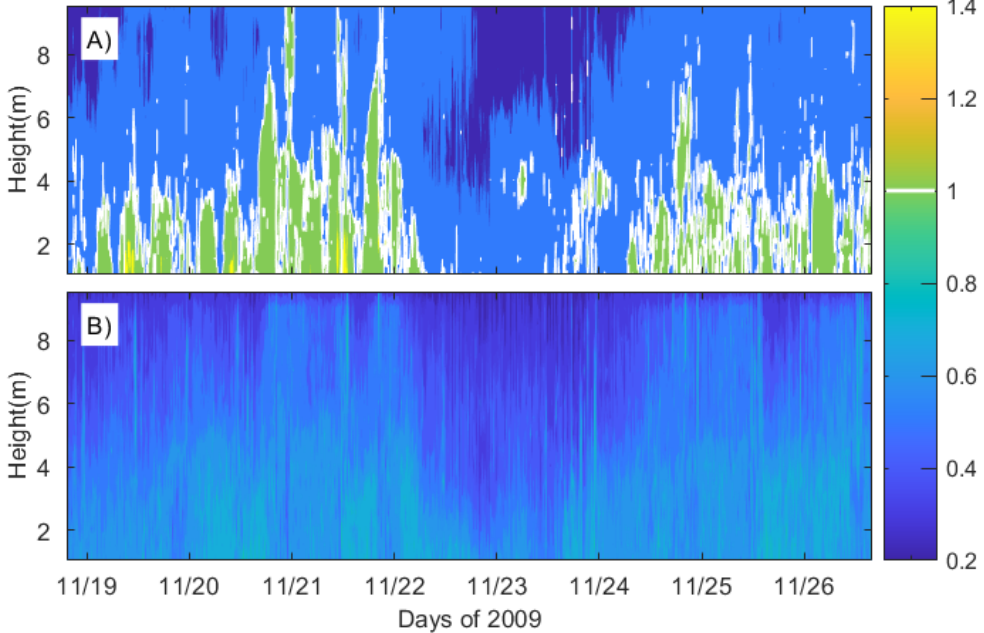
Figure 9. Standard deviation ( A ) of VAF method Reynolds stress estimates ( −𝒖 ′ 𝒘 ′ ) and ( B ) of HA method Reynolds stress estimates, normalized by that of original Reynold stress estimates. The white line represents the value 1.